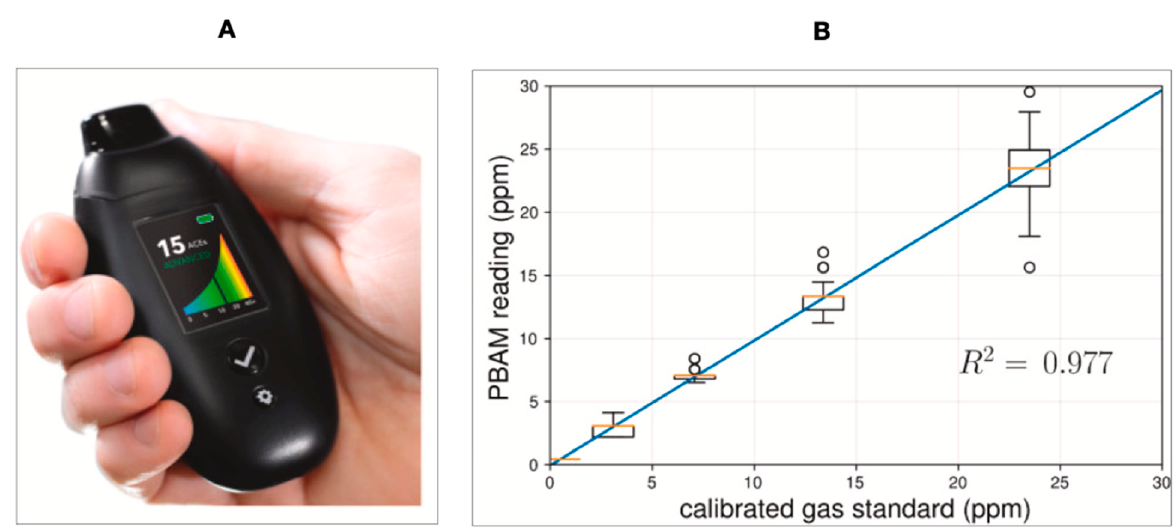
Figure 5. ( A ) PBAM developed by Readout Health [87]; ( B ) Performance of three calibrated PBAM’s against a laboratory gas standard [87]. Reprinted with permission from the BIOSENSE.